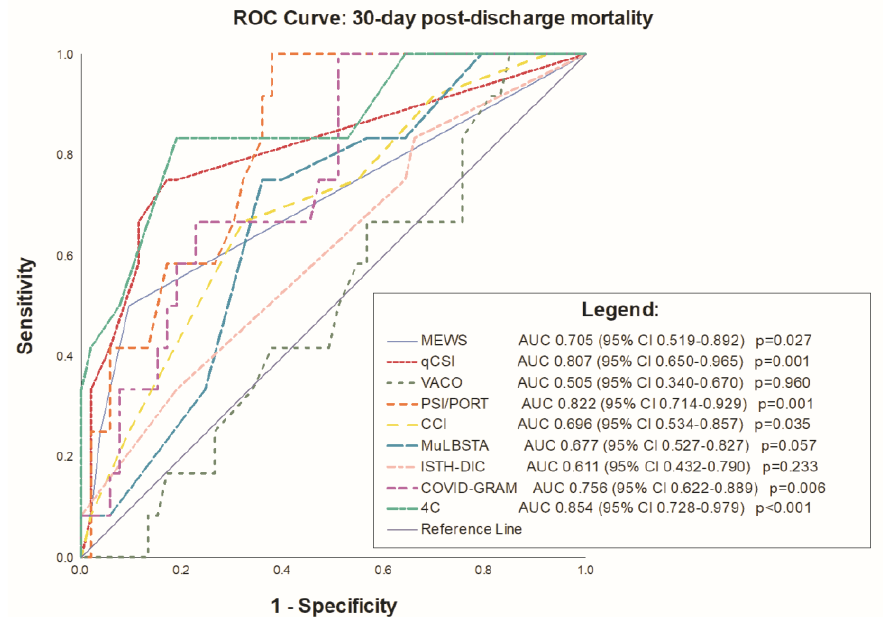
Figure 2. Receiver operating characteristics of the risk scores. Abbreviations: 4C Mortality Score—